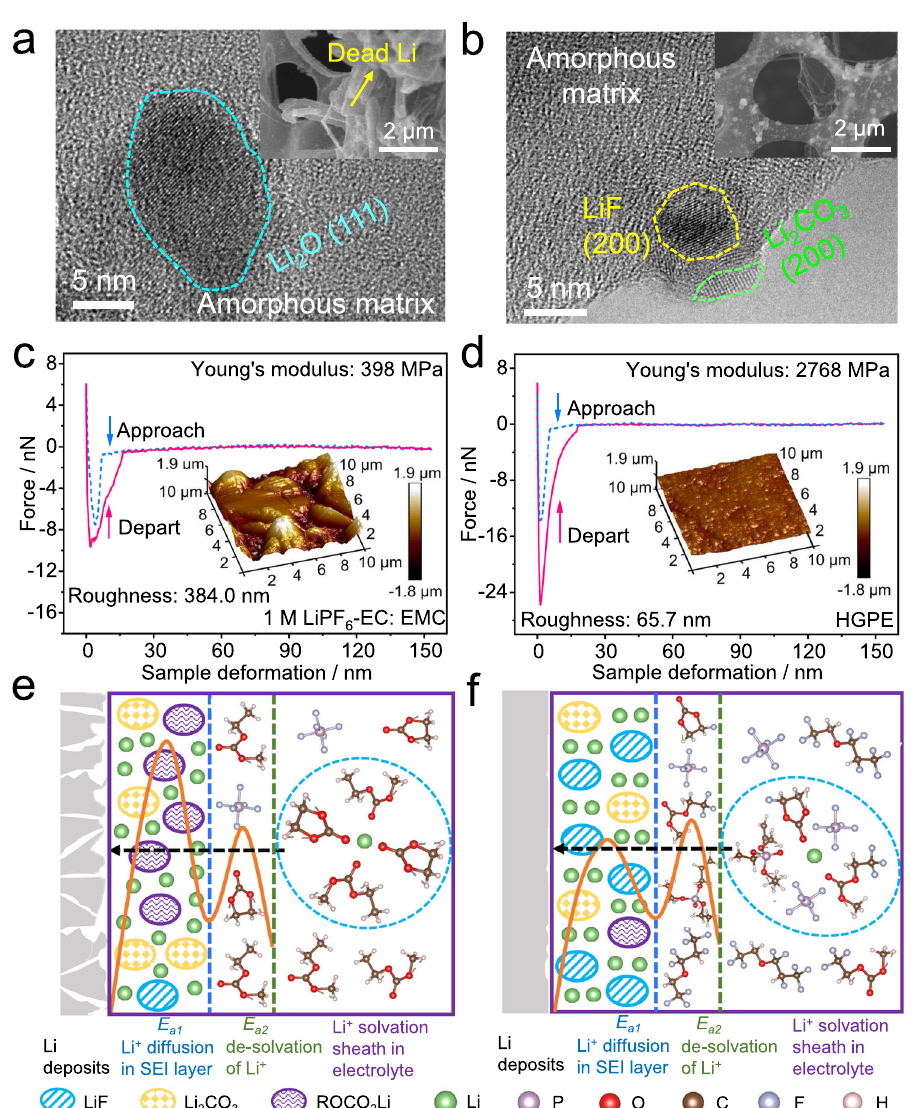
Fig. 4 Experimental and theoretical investigations of the SEI on Li metal. a , b TEM image of the SEI shell formed by repeatedly plating/stripping Li on Cu grids in a 1 M LiPF 6 -EC: EMC electrolyte and b HGPE. c , d Force-displacement plots of c 1 M LiPF 6 -EC: EMC derived SEI and d HGPE derived SEI. Corresponding three-dimensional atomic force microscope (3D-AFM) scanning images of SEI layers are shown in insets. e , f Schematics of the Li + deposition process in e 1 M LiPF 6 -EC: EMC electrolyte and f HGPE. The aggregates in the light-blue dotted ovals represent the Li + solvation sheath in the bulk electrolyte. The curves correspond to the activation energies of E a1 and E a2 . Scale bars: 5 nm in Fig. 4a, b; 2 μ m in the insets of Fig. 4a,